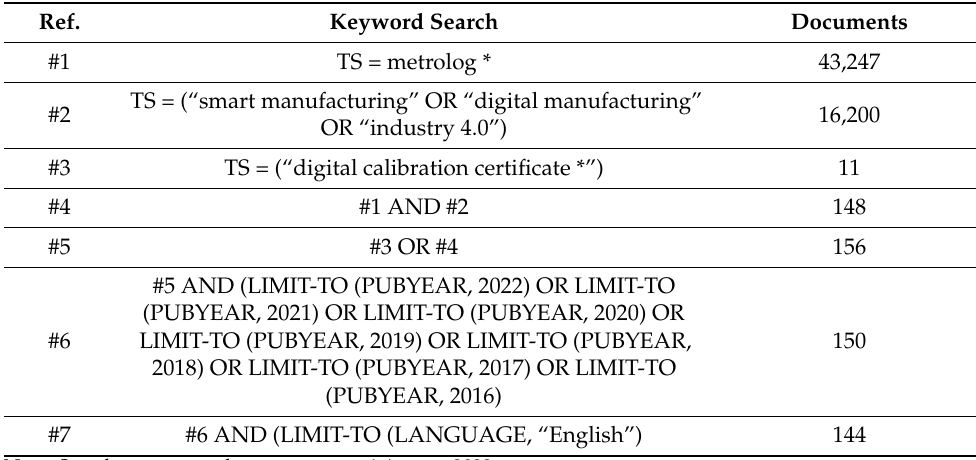
Table A1. Search strategy in the Web of Science database.